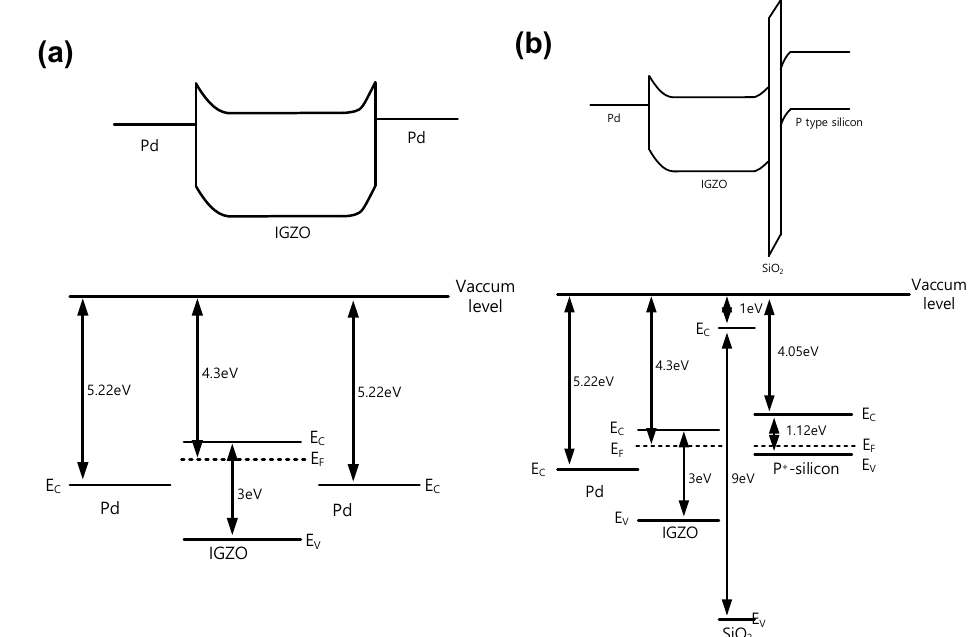
Figure 4. Flat band diagram and energy band diagram in the equilibrium of ( a ) S1 (Pd/IGZO/Pd) and ( b ) S2 (Pd/IGZO/SiO 2 /p-type Si). To confirm the switching mechanism of S2, the ϕ B with respect to the TE voltage is extracted, as shown in Figure 5a, using the following equation: 𝐼 (cid:3019)(cid:3019)(cid:3002)(cid:3014) 𝑞 𝑙𝑛(cid:3436) (cid:3440) = 𝜙 (cid:2886) (1) 𝑘𝑇 𝑉 (cid:3021)(cid:3006) where T is the absolute temperature, q is the amount of charge, and k is the Planck con- stant. It is verified that the ϕ B is gradually modulated from 0.38 eV to 0.11 eV (0.27 eV of ϕ B difference) as the voltage is increased, and accordingly, the device state becomes more conductive by thermionic emission. The ϕ B is also extracted from the Arrhenius plot of 𝑙𝑛(cid:4672) (cid:3010) (cid:3267)(cid:3267)(cid:3250)(cid:3262) (cid:3021) (cid:3118) (cid:4673) for both states (LRS and HRS), as shown in Figure 5b, which also confirms that the ϕ B difference is 0.24 eV, and two states can be programmed according to the ϕ B mod- ulation. Figure 5c illustrates the change in the ϕ B with respect to the applied voltage and movement of electrons using an energy band diagram. The ϕ B modulation can be ex- plained by the electric field-induced oxygen ion migration, depending on the bias condi- tions [49,50]. At a low voltage, electrons cannot move easily because of the SB between the SiO 2 layer and p-type Si BE. However, as the voltage is increased, oxygen vacancies at the interface of SiO 2 -Si are placed higher than the Fermi level, and they are ionized into V O2+ and electrons. The electric field generated by V O2+ ions reduces the ϕ B , which allows elec- trons to cross the SB (set process). On the other hand, when a negative voltage is applied, the energy state of the oxygen vacancies is lower than that of the Fermi level, and the ionized V O2+ becomes neutralized V O . Therefore, the lowered ϕ B by ionized V O2+ is restored to its original height, and it becomes difficult for electrons to cross the SB (reset process).